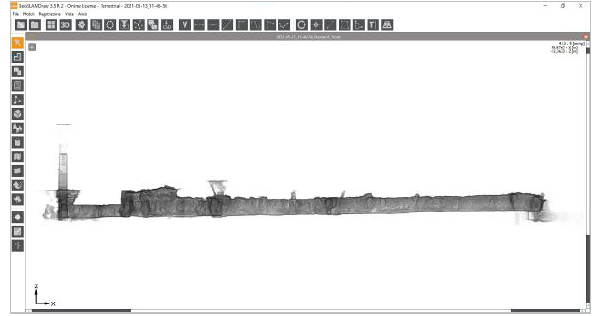
Figure 9. GeoSLAM Draw interface. Side section view in orthogonal projection of the point cloud of “Gesuitico Alto” qanāt .